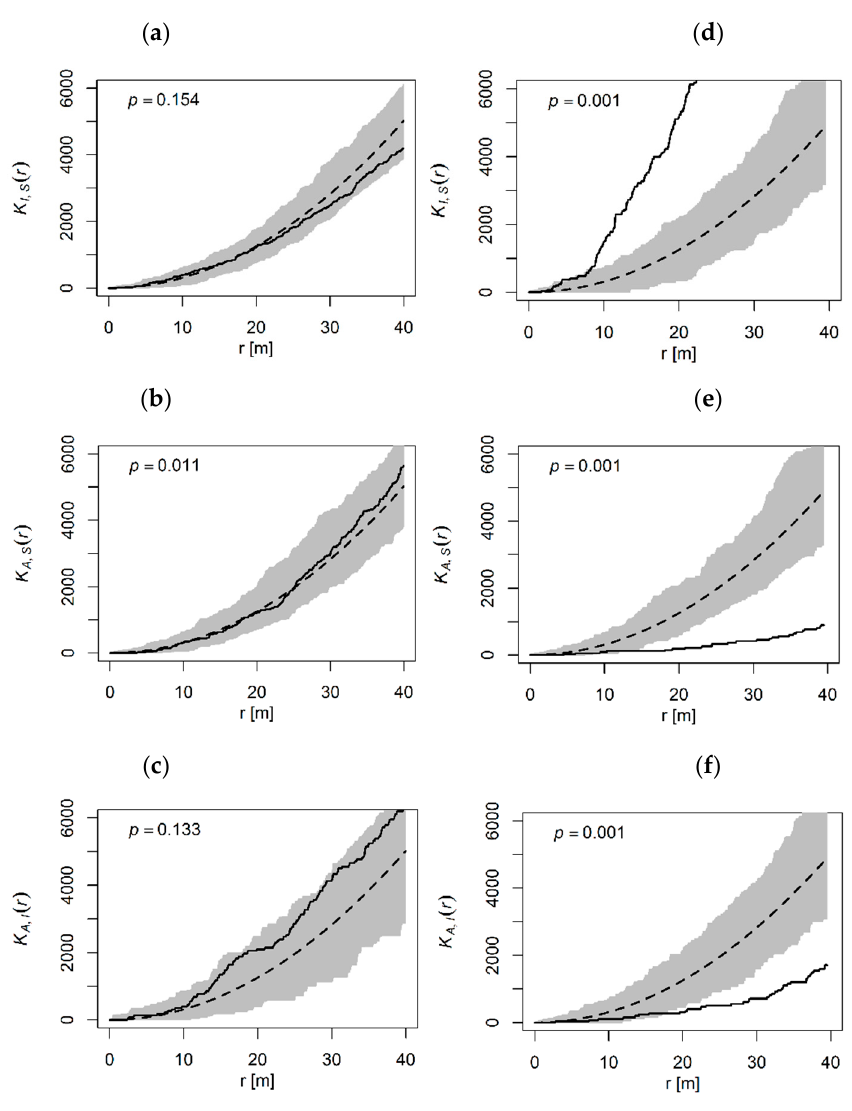
Figure 4. The spatial relationship (cross-k function Kij (r)) between individuals belonging to different tree size classes. The solid line shows observed Kij (r) values, the dashed line denotes the complete spatial randomness (CSR) and the gray area represents the 95% confidence interval. ( a , d ): Intermediate–Sapling, ( b , e ): Adult–Sapling, ( c , f ): Adult–Intermediate.